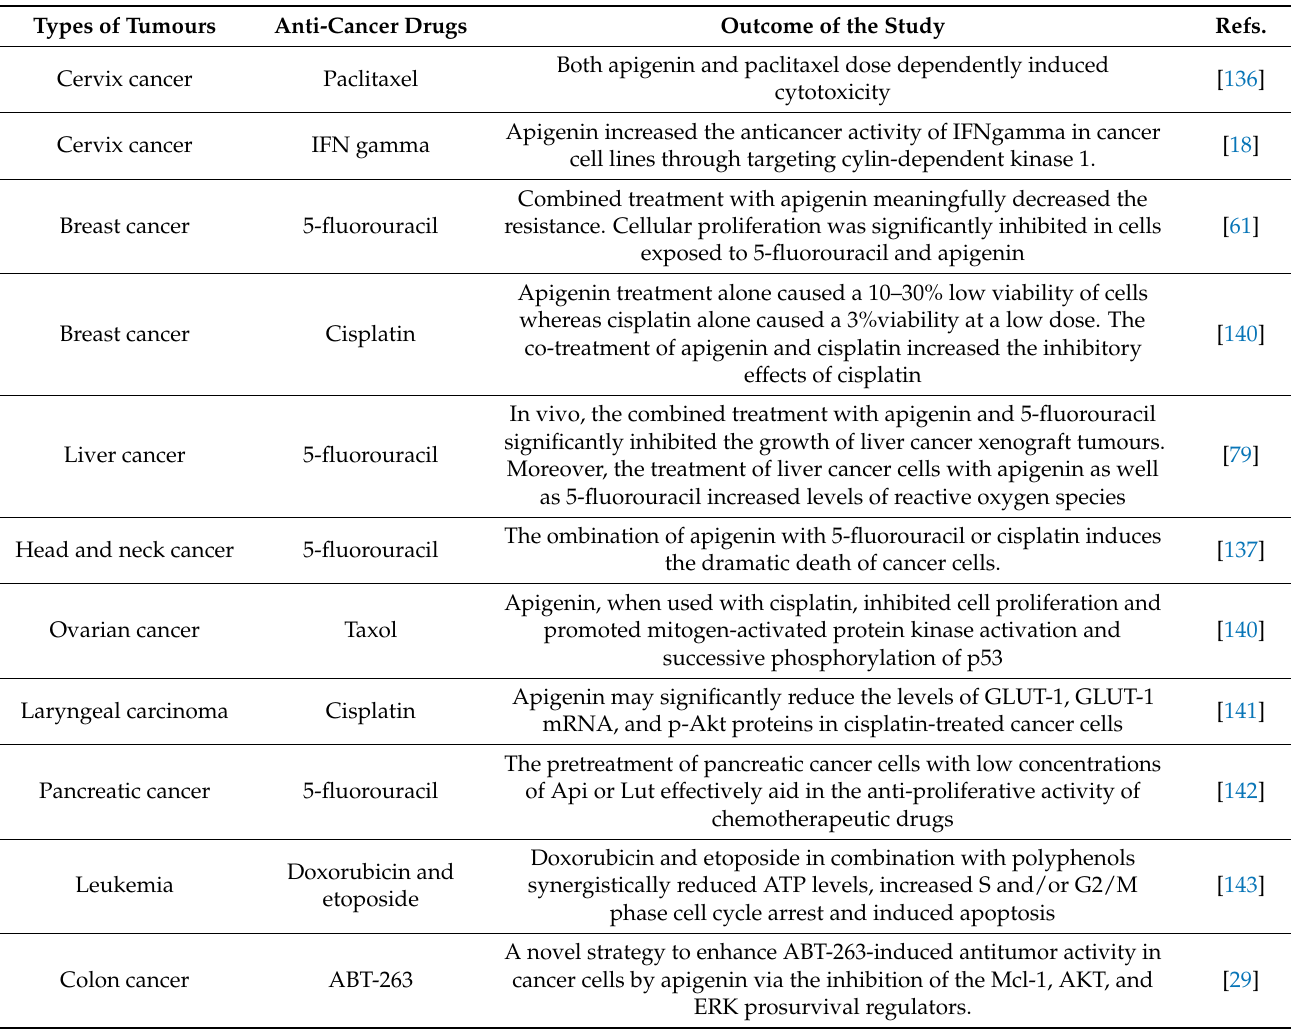
Table 3. Synergistic effect of apigenin with anti-cancer